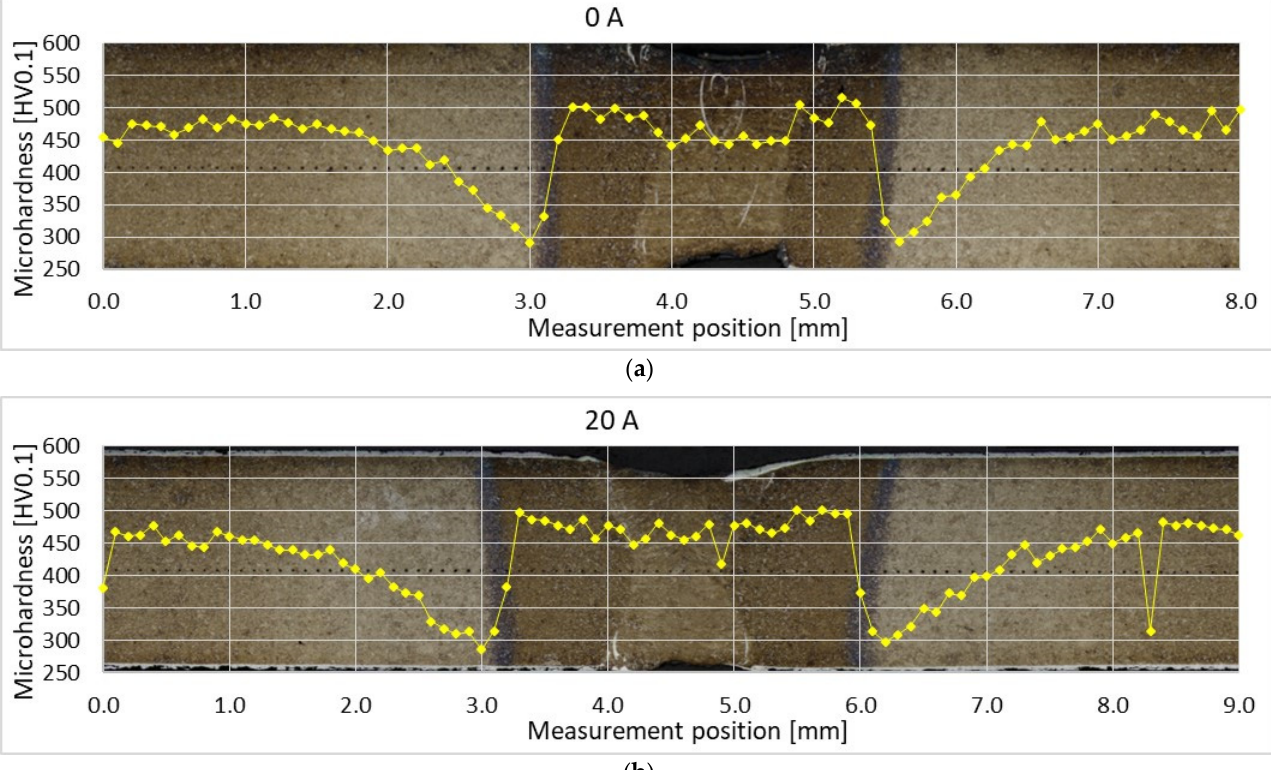
( c ) ( d ) Figure 11. Microhardness of ( a ) laser weld and hybrid welds made with ( b ) 20 A, ( c ) 40 A, and ( d ) 60 A. Both the width of the surface coating and the dimensions of white-appearing regions are relatively small. Therefore, the load had to be reduced to investigate their microhard- ness. The surface coating after hot stamping is hard and brittle and reaches (1065 ± 40) HV0.025. The microhardness of the ferritic region in FZ of laser weld is only (270 ± 12) HV0.025. The positions and appearance of indents are visible in Figure 12.